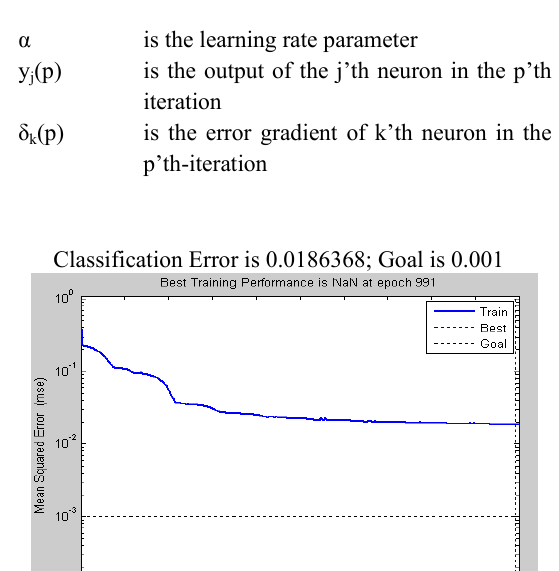
Fig 3: Chromosome for the Iris Data